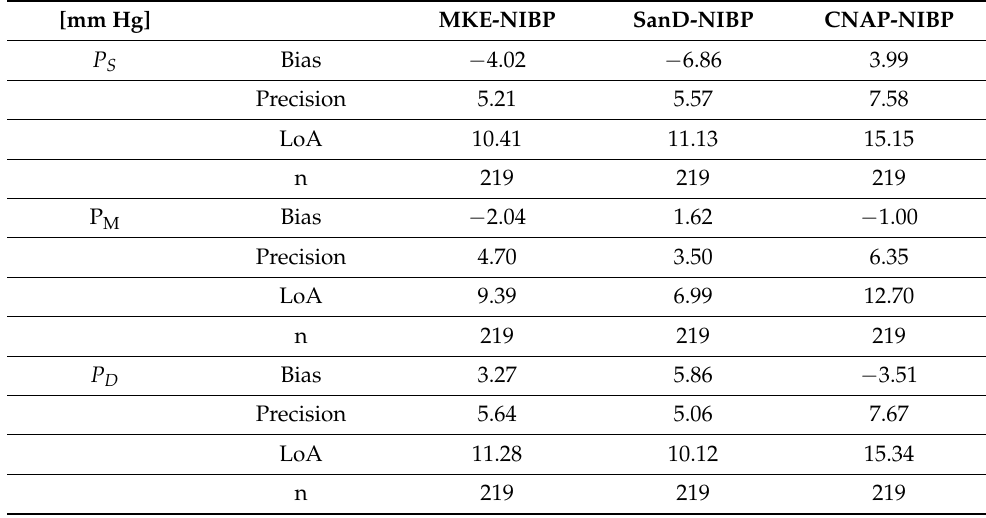
Table 3. Analysis according to Bland and Altman [22,23] for the test procedure against the reference NIBP. Bias = test - ref; Precision = ± 1 sd; Limits of Agreement (LoA) = ± 1.96 sd. [mm Hg] MKE-NIBP SanD-NIBP